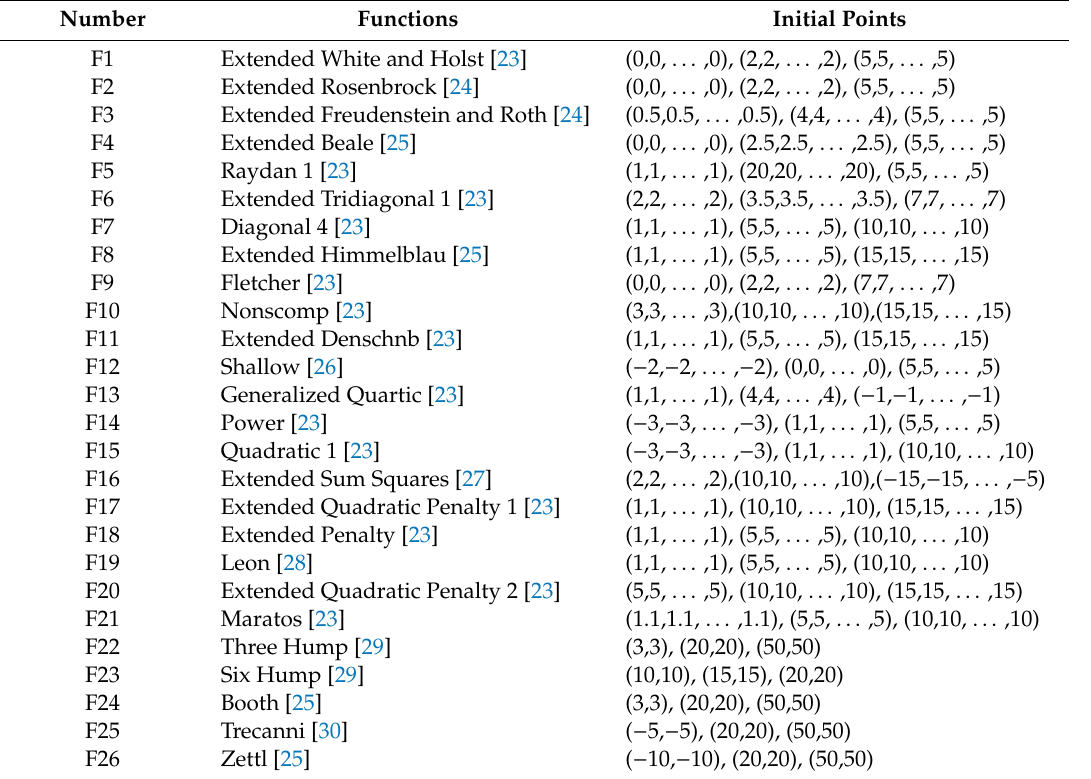
Table 1. List of test